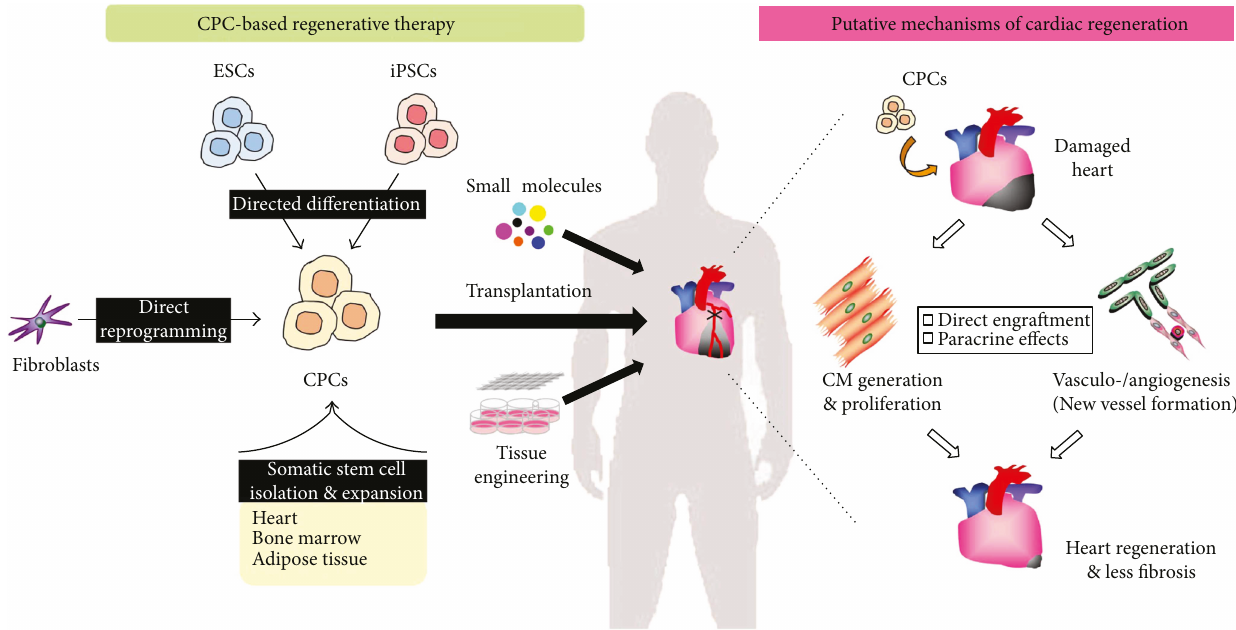
Figure 1: CPC-based regenerative therapy for heart disease. Cardiac progenitor cells (CPCs) can be obtained through several approaches (left). Directed di ff erentiation of pluripotent stem cells such as embryonic stem cells (ESCs) or induced pluripotent stem cells (iPSCs) can generate “ developmental (embryonic) ” CPCs, while isolation and expansion of tissue- (i.e., heart) resident stem/progenitor cells can generate “ adult ” CPCs. Recently, an alternative approach by employing direct reprogramming can also generate “ inducible ” CPCs. These puri fi ed and expanded CPCs combined with small molecules and/or tissue engineering can be therapeutically transplanted into the damaged hearts of patients, such as those su ff ering from ischemic cardiomyopathy. Putative cellular mechanisms of cardiac regeneration by CPC-based therapy (right). Transplanted CPCs can be engrafted directly into the damaged host cardiac tissue and di ff erentiated into mature cardiomyocytes as well as vascular cells (smooth muscle cells and endothelial cells). Simultaneously, the CPCs can potentially promote proliferation of preexisting cardiomyocytes in the damaged heart and also induce vasculo-/angiogenesis in the ischemic regions through secretion of the paracrine factors. Theoretically, increased working cardiomyocytes and newly formed vessels could lead to e ff ective heart regeneration and a reduction in cardiac fi brosis in a coordinated fashion. Further details for cell-free approaches (e.g., small molecules and tissue engineering), somatic stem cell-expansion derived from bone marrow and adipose tissue, and CPC therapy-related mechanisms for cardiac regeneration have been reviewed elsewhere [6,